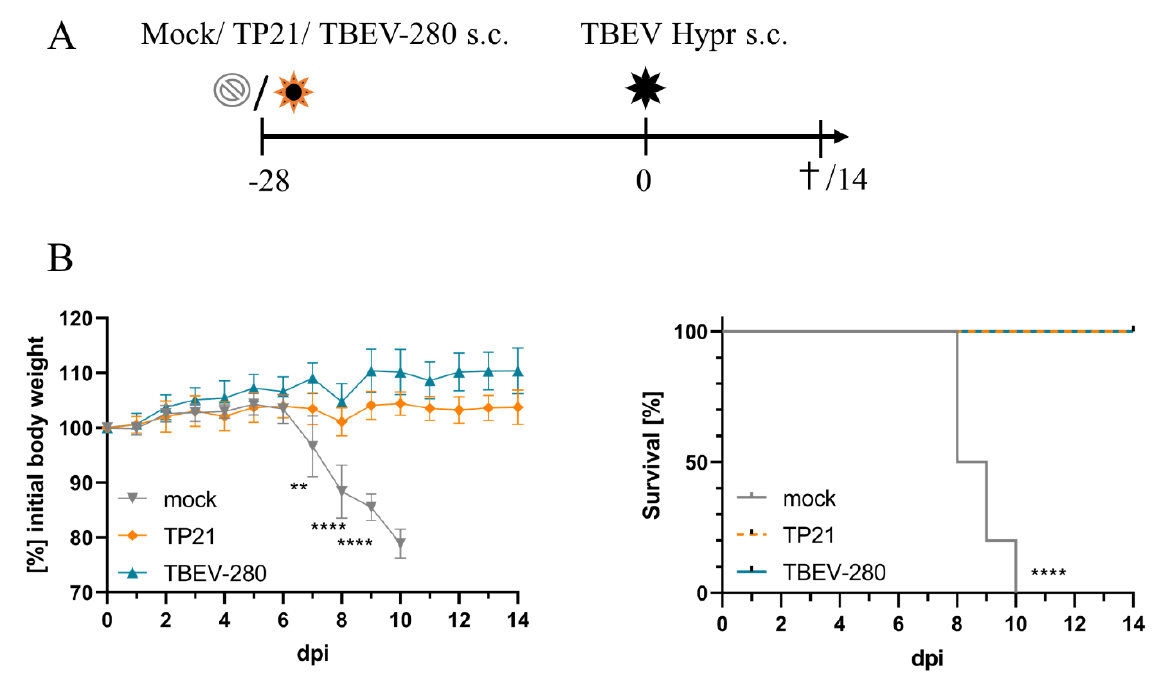
Figure 1. Low-virulent Langat virus (LGTV (TP21)) and naturally avirulent tick-borne encephalitis virus (TBEV (TBEV-280)) immunization protects mice from highly pathogenic TBEV (TBEV-Hypr) challenge († = time of sacrifice). ( A ) Schematic representation of the study. ( B ) Changes in body weight and the survival of the mice post TBEV-Hypr challenge was monitored for a period of 14 days. Data is presented as mean ± SD ( n = 10) of percentage change relative to initial body weight on the day of TBEV-Hypr challenge. Body weight data was analyzed using unpaired Student’s t -test and survival data analyzed by log-rank test (** p < 0.01, **** p < 0.0001).